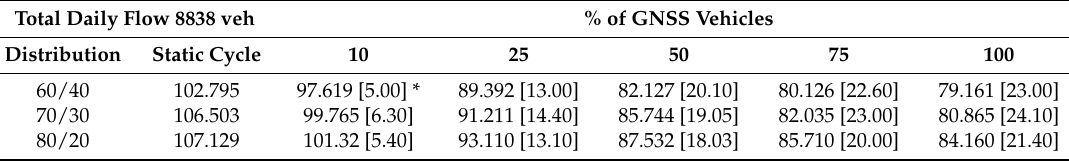
Table 8. Average CO2 pollution [g/km], in a typical day, for Case B.